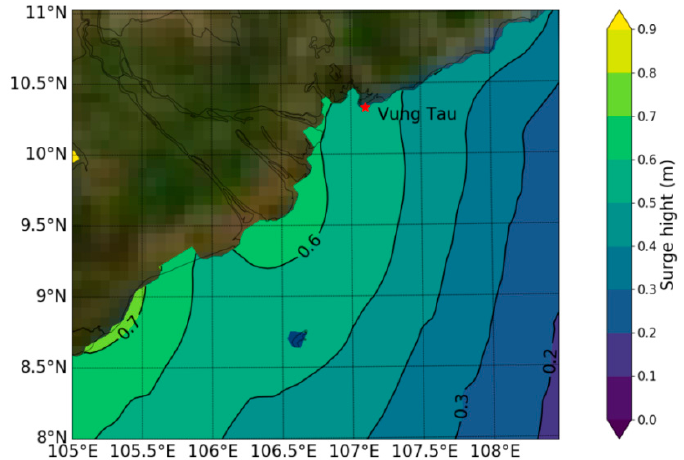
Figure 15. Maximum surge during 16–26 October 2013.